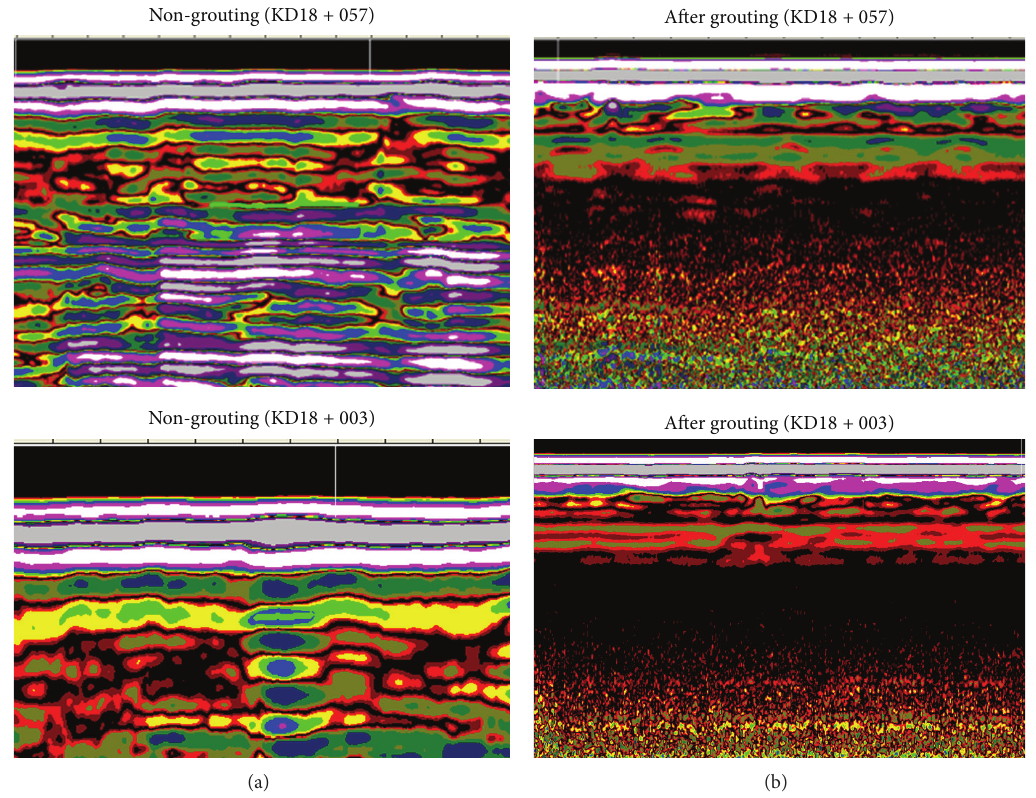
Figure 14: The comparison between grouting and non-grouting